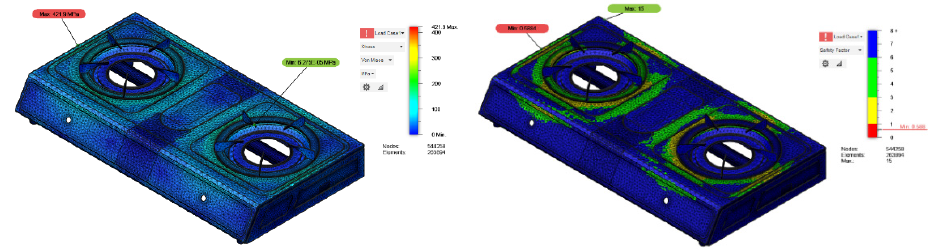
Figure 7. Maximum stress and minimum factor of safety of the existing stove .